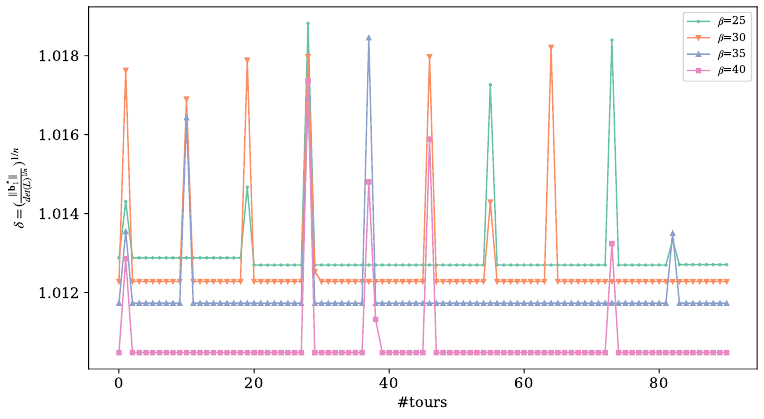
Figure 3. The evolution of δ during reprocessing, n = 120, k = 8, β =